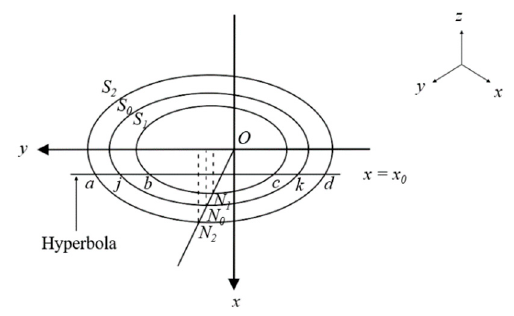
Figure 7. Projection diagram of disc section.